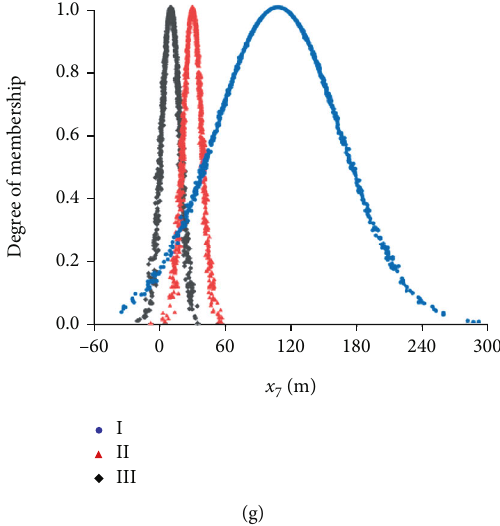
Figure 5: Normal cloud of each index belonging to each risk grade. Table 5: Working face index data.